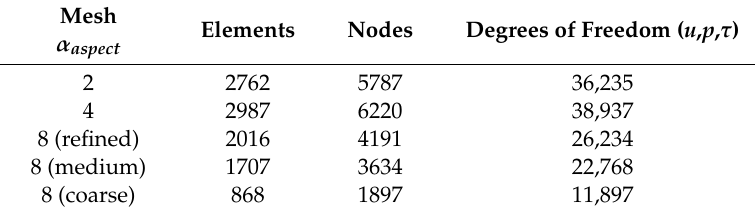
Table 1. Mesh characteristics, di ff erent contraction